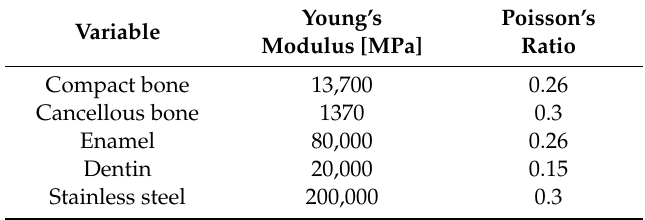
Table 1. The mechanical properties of the components of the finite element model constructed for the present study.